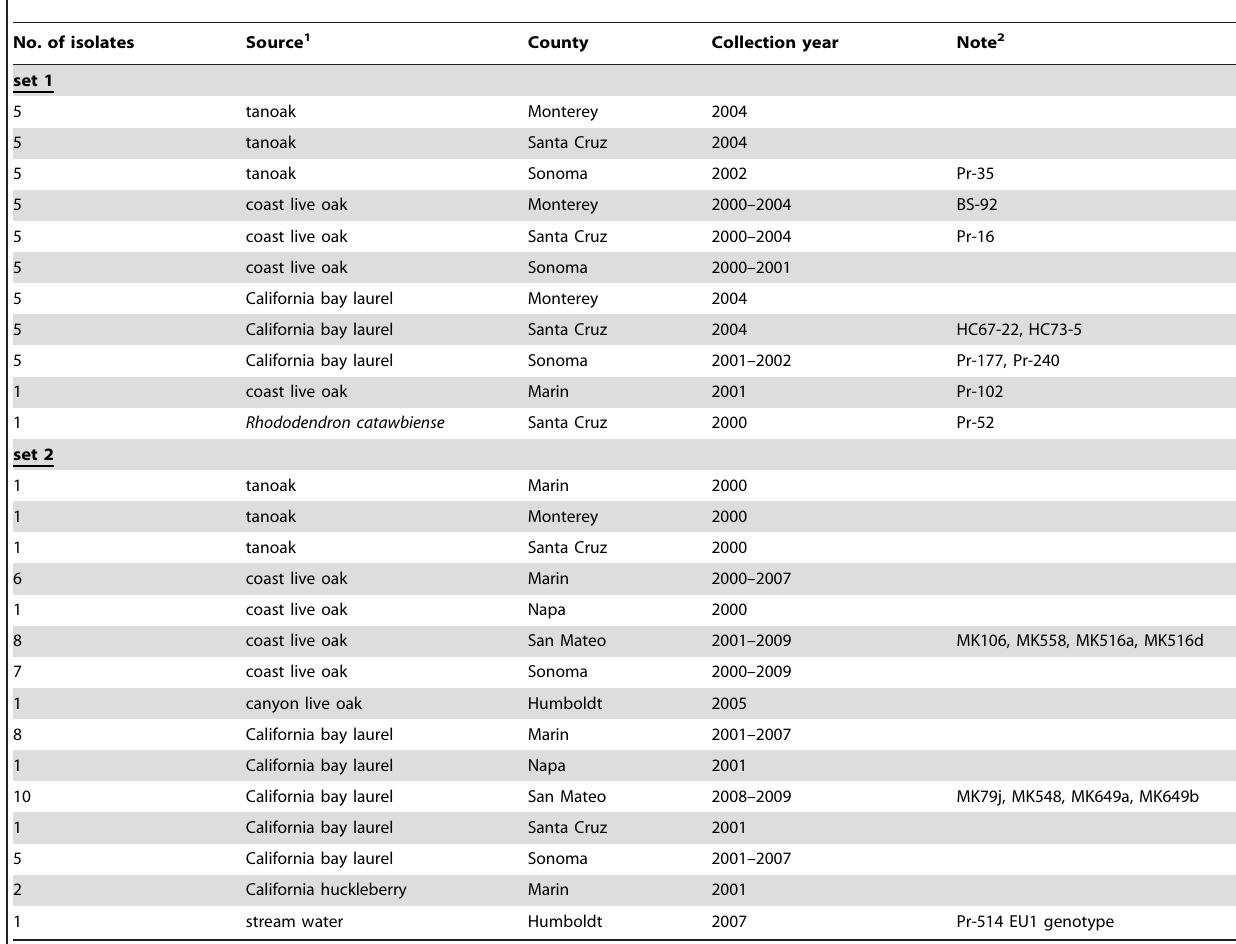
1 Table S2 for detailed information for individual isolates. Scientific names are: tanoak, Notholithocarpus densiflorus ; coast live oak, Quercus agrifolia ; canyon live oak, Quercus chrysolepis ; California bay laurel, Umbellularia californica ; California huckleberry, Vaccinium ovatum . 2 Isolates described in the main text are shown.